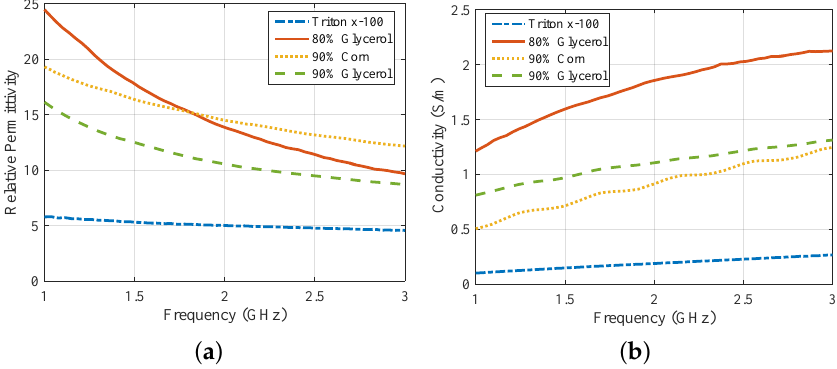
Figure 3. Measured ( a ) relative permittivity and ( b ) conductivity for the immersion liquids considered in this study (material properties of Triton X-100 were measured at Politecnico di